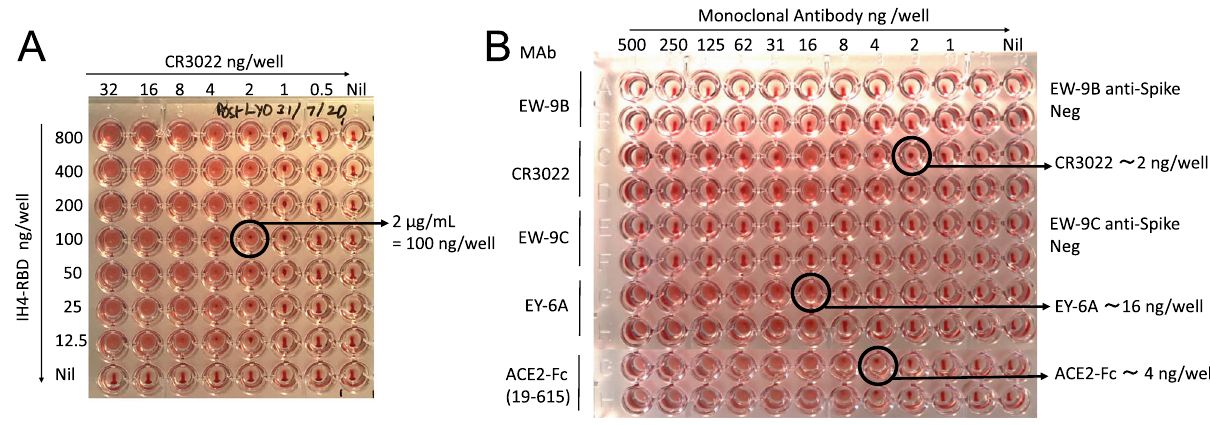
Fig. 2 Haemagglutination with human monoclonal antibodies or nanobodies to the SARS-CoV-2 RBD. A Titration of IH4-RBD and monoclonal antibody CR3022 to RBD. Doubling dilutions of CR3022 and IH4-RBD were prepared in separate plates. 50 µ L red cells (O − ve whole blood diluted 1:40 in PBS) were added to the CR3022 plate, followed by transfer of 50 µ L titrated IH4-RBD. From this titration, 100 ng/well of IH4-RBD was chosen for detection. Similar results were obtained in fi ve other experiments, performed with three separate batches of IH4-RBD. B Detection of other anti-RBD monoclonal antibodies and ACE2-Fc. Doubling dilutions of monoclonal antibodies were prepared in duplicate in 50 µ L PBS (from a stock solution of 20 µ g/mL) from left to right, 50 µ L of 1:40 O − ve red cells were added, followed by 50 µ L of IH4-RBD (2 µ g/mL in PBS). The endpoint was de fi ned as the last dilution without teardrop formation on tilting the plate for ~30 s. The binding sites for CR3022, EY6A, and ACE2 on RBD have been de fi ned 8,10,27,30 . EW-9B and EW-9C are monoclonal antibodies against non-RBD epitopes on the spike protein 28 . ACE2-Fc has been described in ref. 28 . Similar results were obtained in two other titration